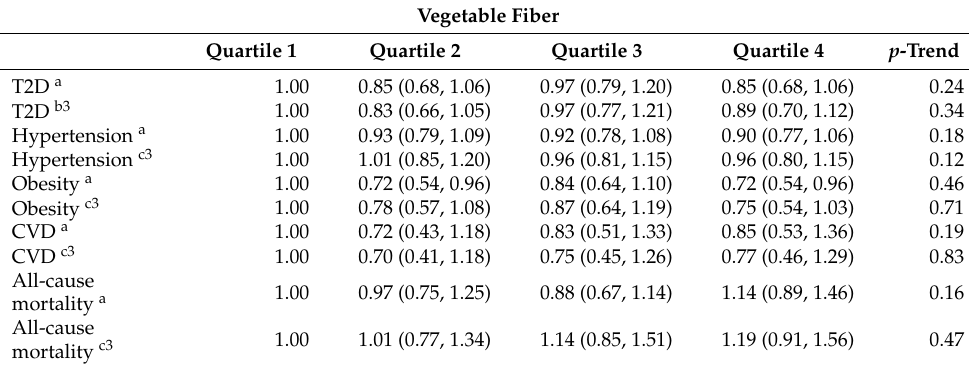
Table 5. Multivariable adjusted HRs (95% CI) of T2D, hypertension, obesity, CVD, and all-cause mortality according to quartiles of vegetable